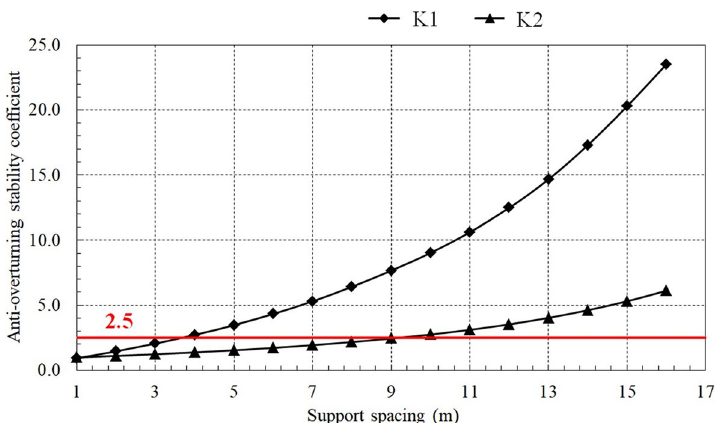
Fig. 20 Comparison of calculation results of two algorithms